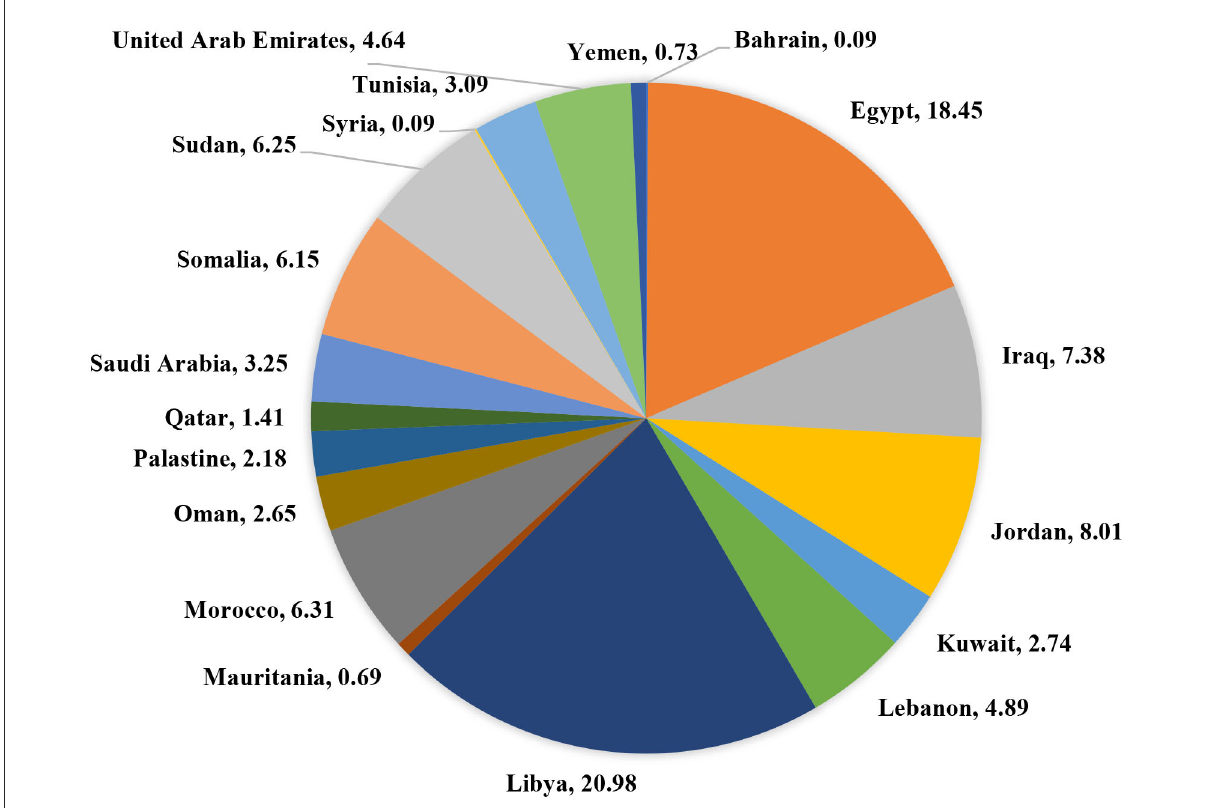
FIGURE1 Country of residence of the